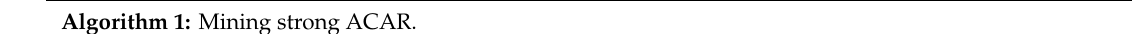
Algorithm 1: Mining strong